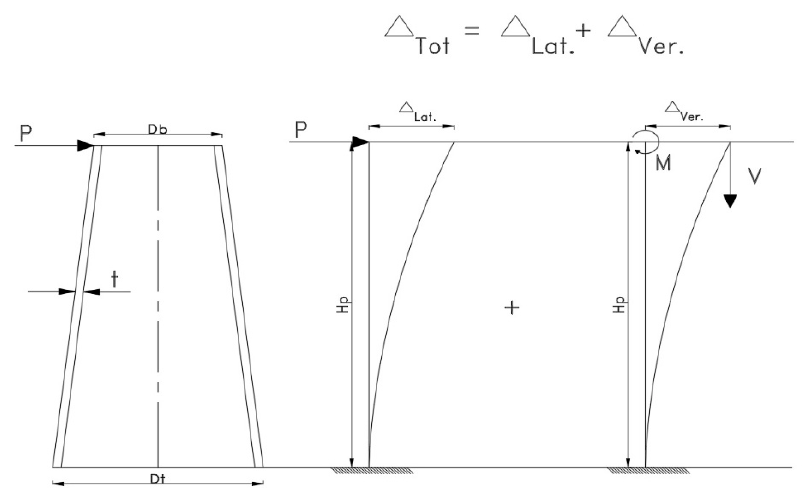
Figure 10. Pole test.